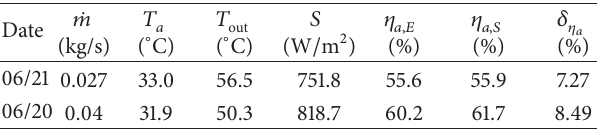
Table 2: Air heating efficiency of the collector under different operating conditions (E: experimental; S: